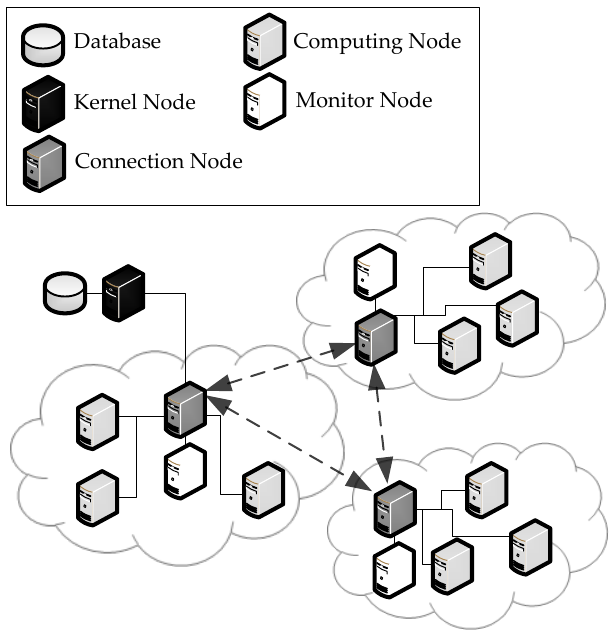
Figure 1. System structure of the fast distributed mining in changing network bandwidth (FDCNB-MINING) algorithm.